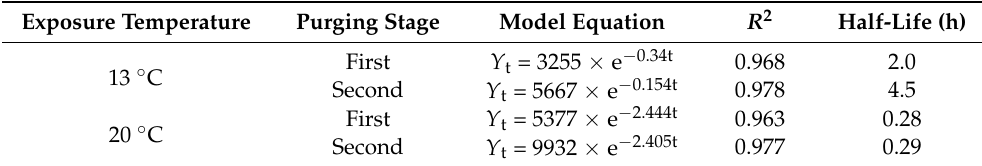
Table 1. Depletion models for eugenol in fillet tissue from sea bass exposed to a concentration of 60 mg/L for 3